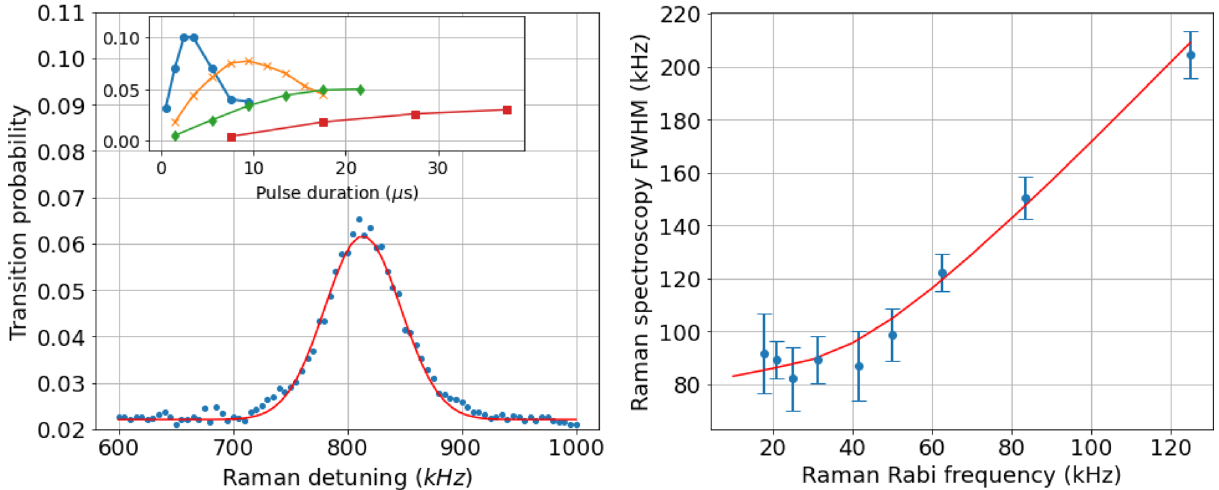
Figure 7. Left: Raman spectroscopy. Transition probability as a function of Raman detuning, for a Rabi 2 π 25 kHz. The gaussian fit (solid line) indicates a full width at half maximum (FWHM) frequency of � = × of 90 kHz limited by the atomic velocity spread. Inset: Transition probability versus duration showing Rabi oscillations for different Raman light intensities. Right: Raman spectrocopy FWHM of the peak for different Raman Rabi frequencies. Each point was extracted from a resonance peak obtained with a Raman pulse adjusted to half the Rabi period. The width of the peak is Fourier limited for large Rabi frequencies but limited 90 kHz by velocity spread for lower values. The solid line shows the expected FWHM as the result of to ≈ numerical integration of the convolution between a gaussian velocity distribution for a temperature T and the profile of a square transition